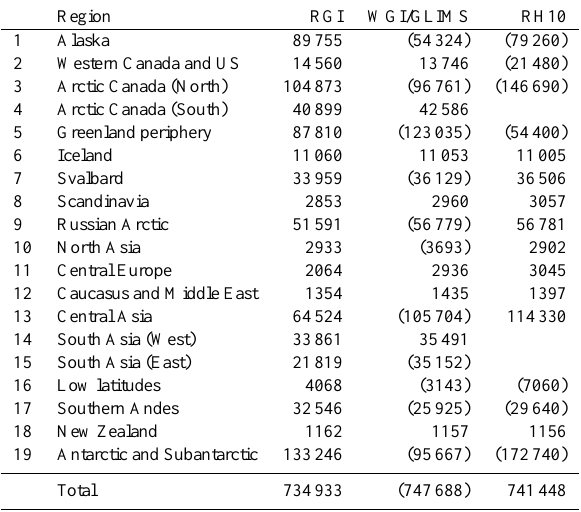
Table 2. Total glacierized area (km 2 ) in each region for three inven- tories. For RH10 (Radi´c and Hock, 2010) the closest correspond- ing regions are shown. RGI contains the best available estimate as the only complete inventory. Numbers in parenthesis mark numbers with known inventory issues, or implied from large disagreement with RGI.